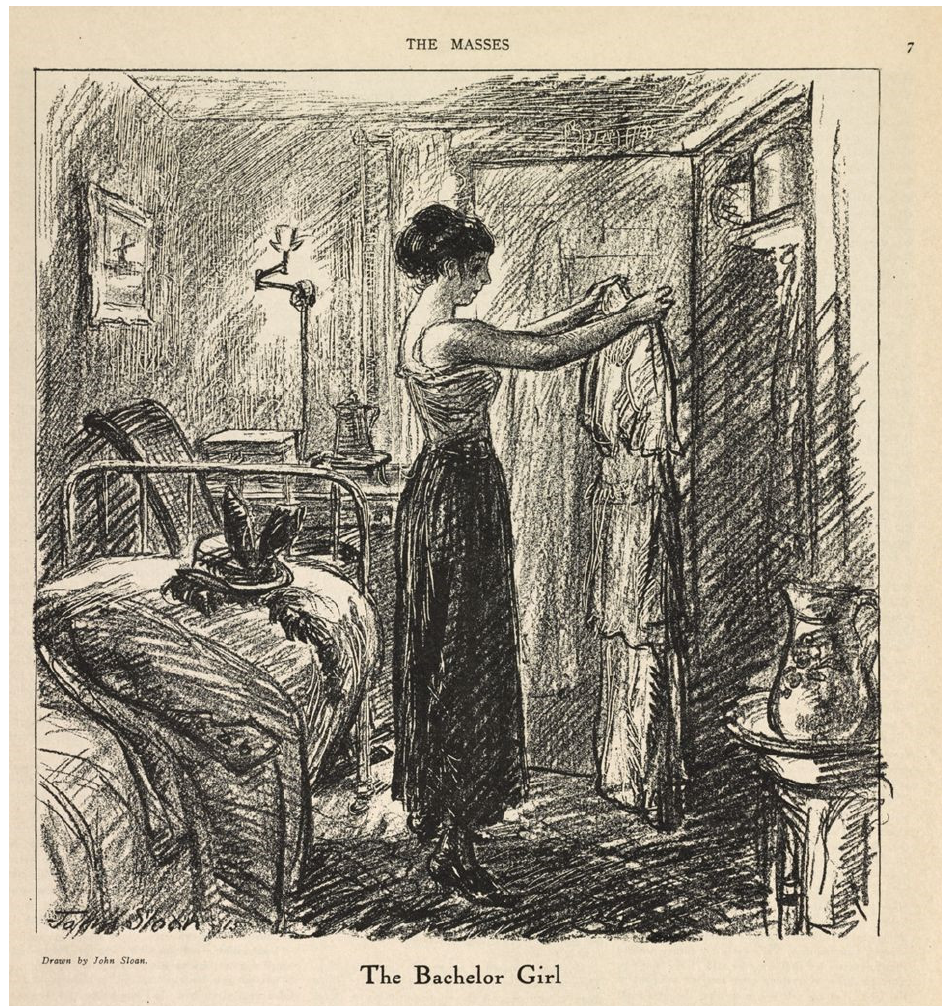
Figure 30. John Sloan. “The Bachelor Girl,” in The Masses V6., No. 5. (February 1915), p. 7. The Modernist Journals Project. Available online: https://modjourn.org/issue/bdr527870/ (accessed on 29 August 2022).